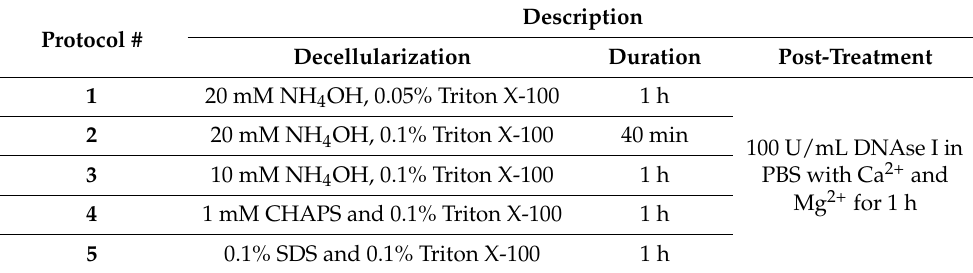
Table 1. The decellularization protocols used in this